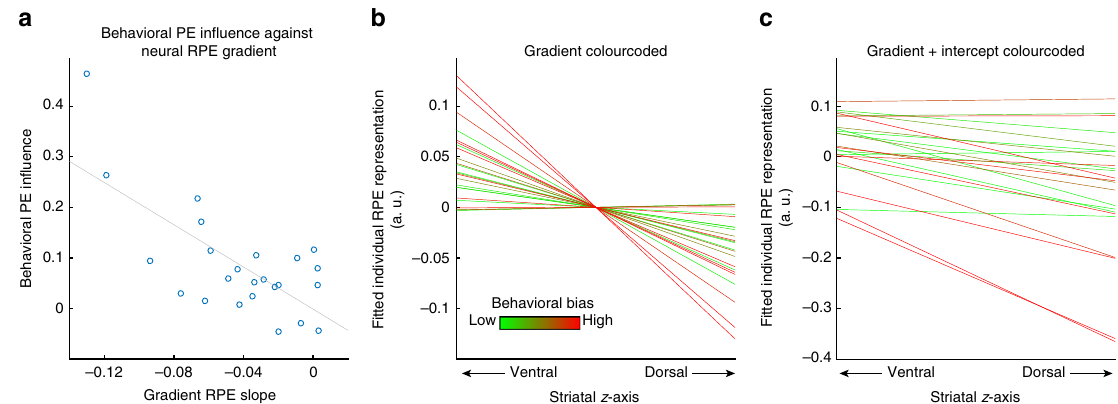
Fig. 6 Gradual RPE integration into the dorsal striatum reduces model-free biases. a Scatter plot of the overall correlation ( r = − 0.70, p = 0.00012) between the individual slopes of the striatal gradients of RPE representation (as in Fig. 3c; averaged over both hemispheres) and the individual behavioural in fl uence of RPEs on belief updating (regression weights displayed in Fig. 2d middle). b Individual striatal gradient slopes (averaged over both hemispheres), colour-coded according to the individual rank order of behavioural bias by RPE (short-term outcomes) on belief updating (red = strong short-term bias, green = low short-term bias). c Same as b with the intercept of the individual regression added to the plotted regression lines. In sum, weaker representations of the RPEs in dorsal striatum were associated with stronger biases of a participant ’ s behaviour by model-free processing of short-term